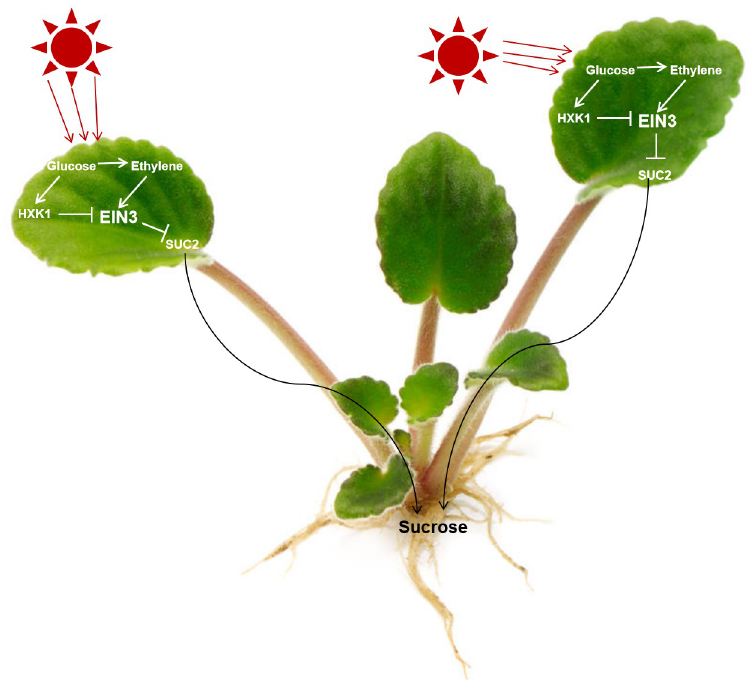
Fig 7. Model illustrating how glucose and ethylene signaling regulates sink root growth of Arabidopsis plants by controlling sucrose phloem loading. Sink root growth is promoted by the glucose signaling-HXK1-EIN3-SUC2 pathway, whereas sink root growth is inhibited by the ethylene signaling-EIN3-SUC2 pathway. The ethylene-EIN3 is ethylene canonical signal transduction pathway, which comprises the ethylene receptors ETR1, CTR1, EIN2, EIN3, and EIL1. The HXK1-EIN3 comprises that the regulation is via regulation of ubiquitination and proteolysis. Arrows and bars represent positive and negative regulation, respectively.